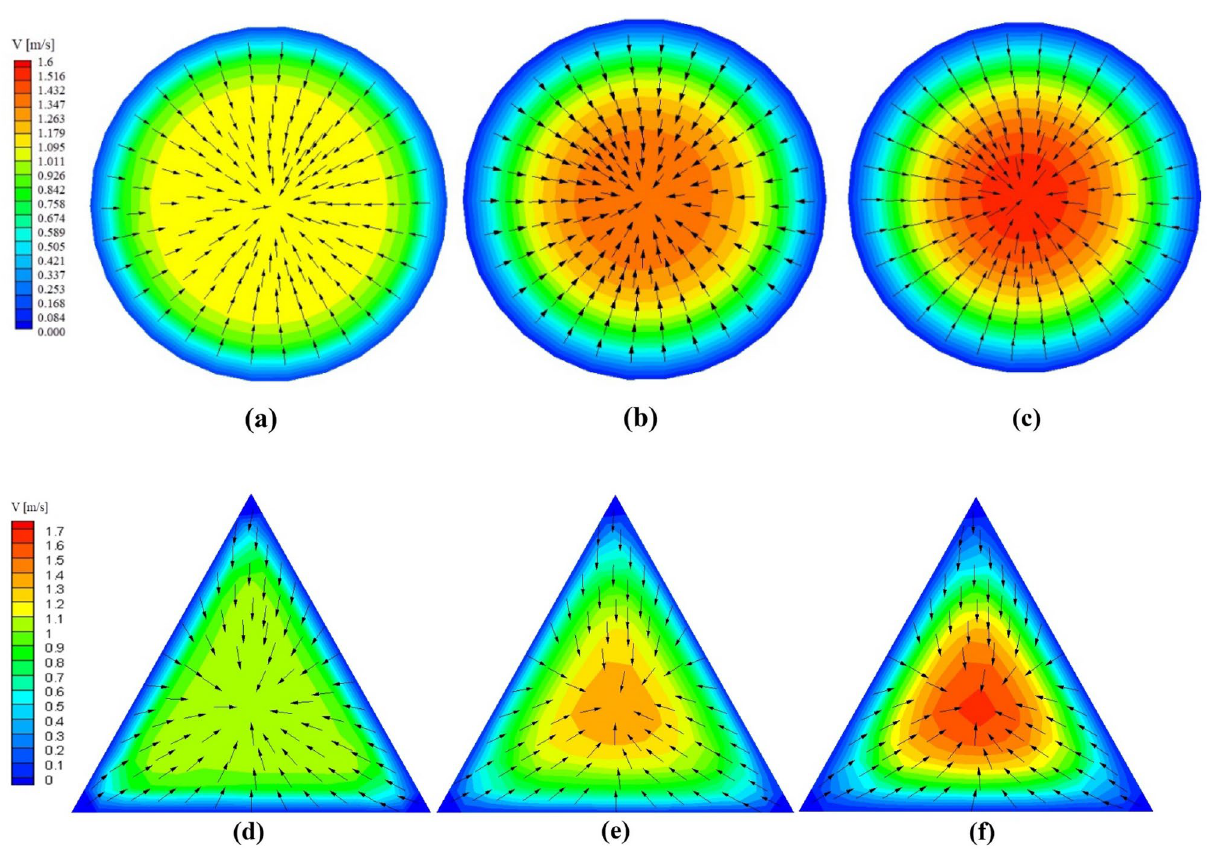
Figure 5. Velocity contours and vectors of circular cross-section at ( a ) x ′ = 0.1, ( b ) x ′ = 0.5, ( c ) x ′ = 0.9, and triangular cross-section at ( d ) x ′ = 0.1, ( e ) x ′ = 0.5, ( f ) x ′ = 0.9.